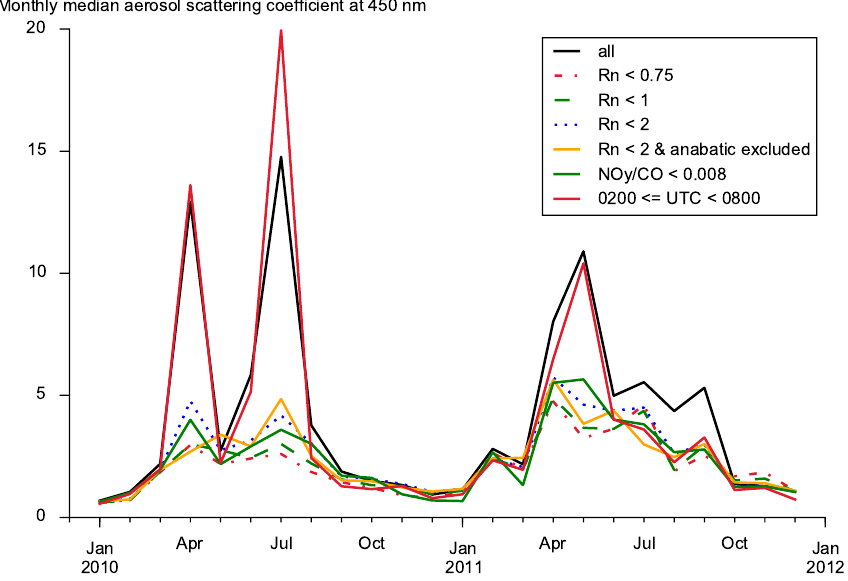
Figure 12. Monthly median aerosol scattering coefficient from different selection criteria: all data; radon concentration less than 0.75, 1, and 2Bqm − 3 STP (the latter with anabatic days excluded); chemical filter based on [ NO y ] / [ CO ] ratio (Pandey Deolal et al., 2013); time-of-day filter. The time-of-day filter is similar to Andrews et al. (2011), keeping data measured during a time window of 03:00–09:00 local time, but we show the median value instead of the